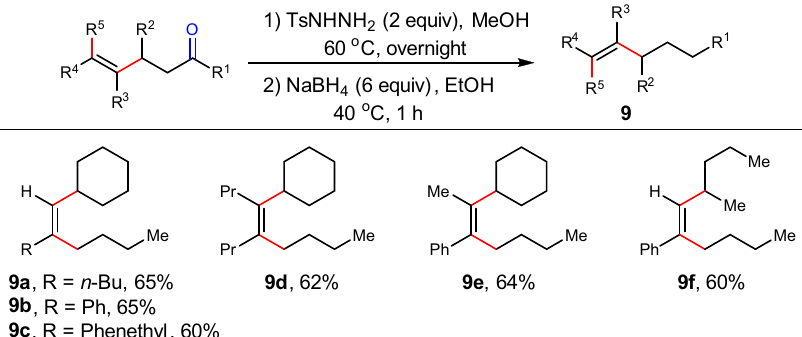
Fig. 4 Synthesis of unfunctionalized tri- and tetrasubstituted alkenes. These results indicate that product of dialkylation of alkynes can be suf fi ciently transformed into unfunctionalized alkenes. Yields are for isolated and puri fi ed products. The detailed procedures have been presented in Supplementary Information (SI).